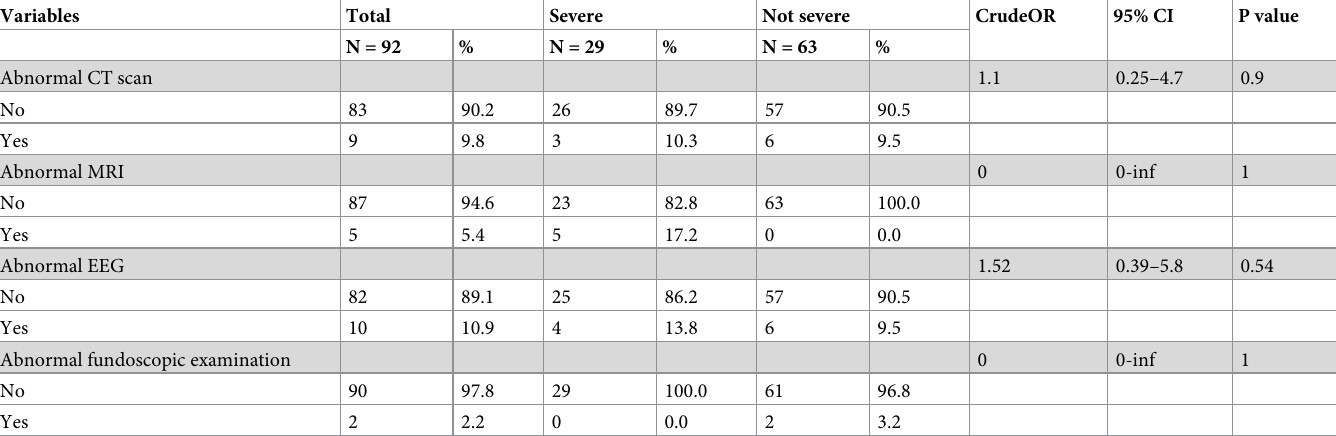
Table 4. Radiological and other paraclinical features of New Caledonian cases of EM from 2004 to 2019 according to severity, n = 92. Variables